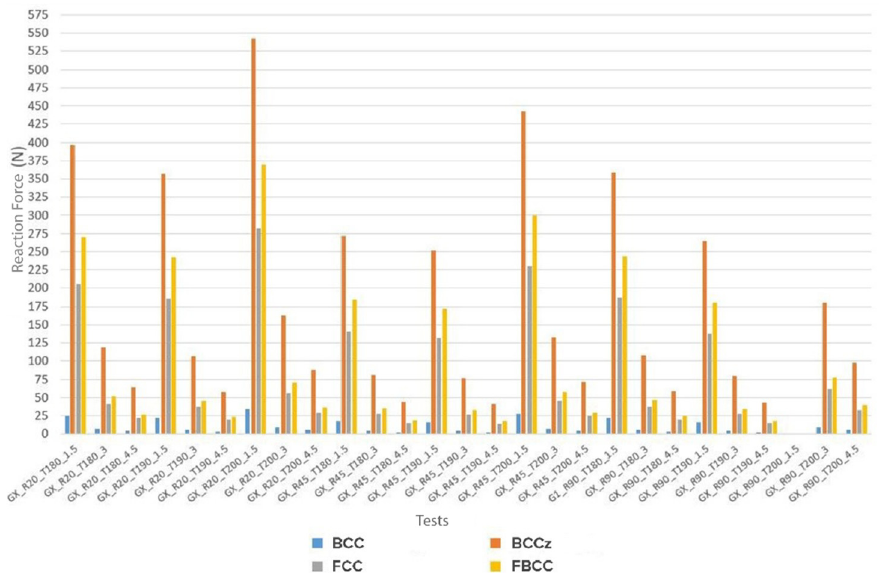
Figure 4. Reaction forces of the different cell topologies. In the term “GX”, X refers to the type of cell topology.